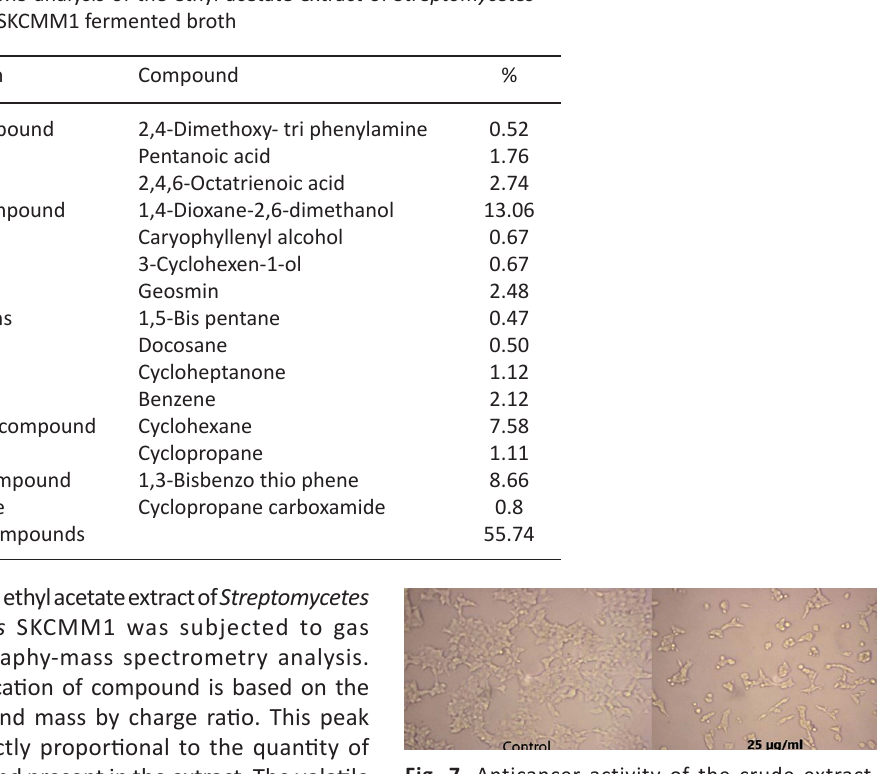
Table 7. GC-MS analysis of the ethyl acetate extract of Streptomycetes